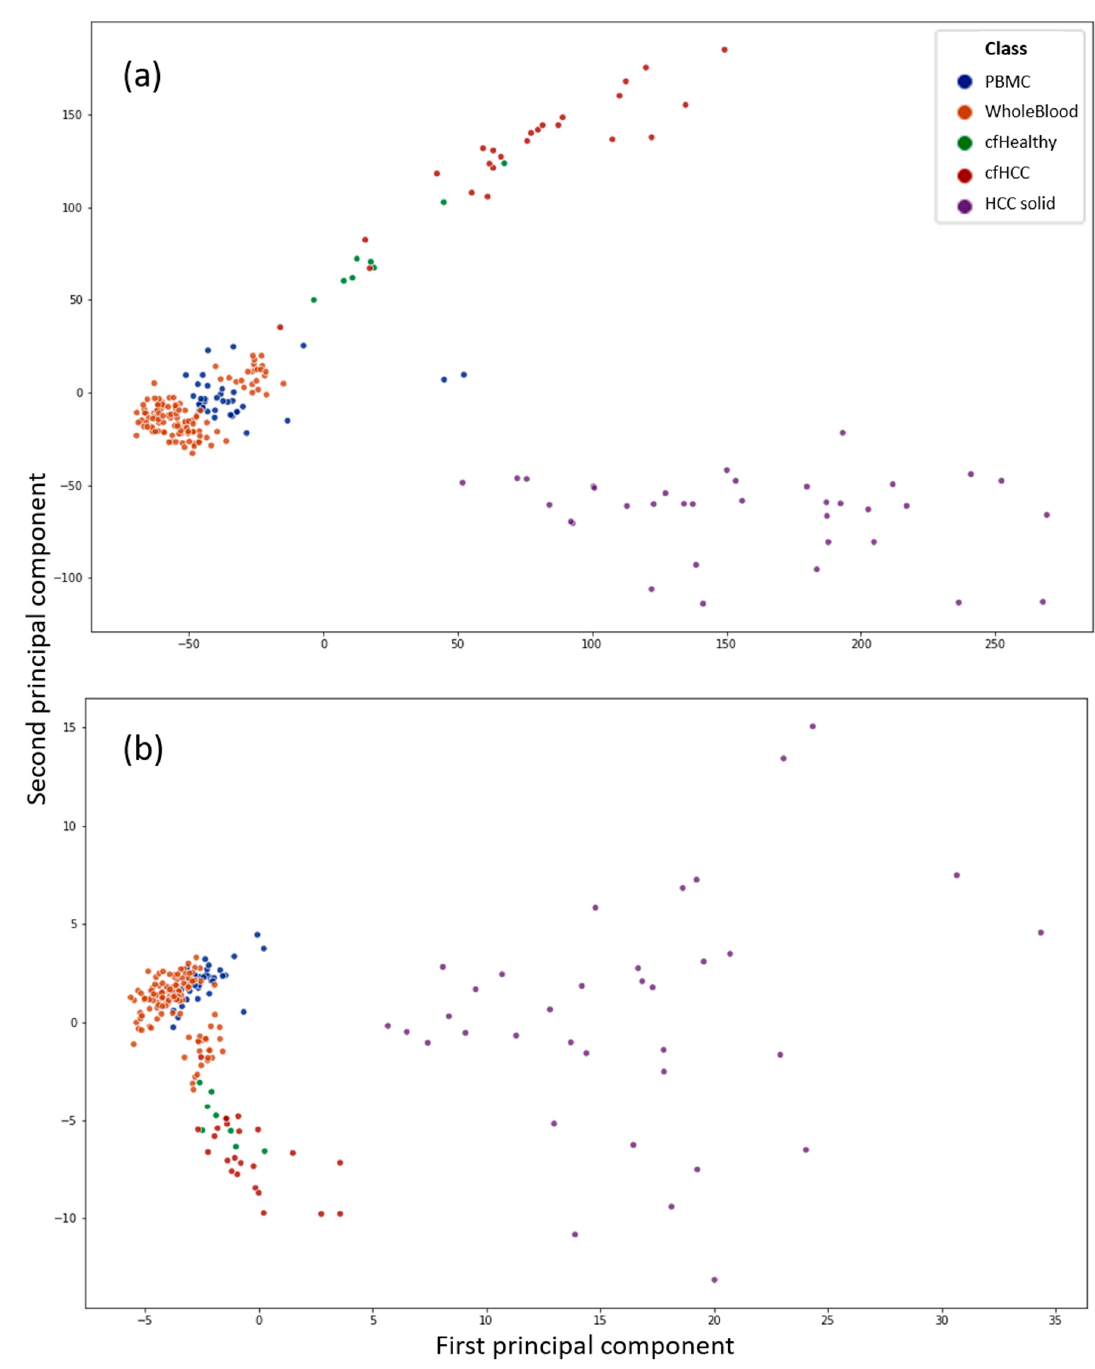
Figure 1. Principal component analysis (PCA) of the complete dataset. The features were in the form of CpG sites in ( a ) or computed CpG islands in ( b ). Blue is associated to purified peripheral blood mononuclear cell (PBMC) samples, while orange shows whole blood samples, where the complete DNA that can be found in a blood sample is extracted without further purification. The violet dots represent solid hepatocellular carcinoma (HCC) samples. Green and red are healthy and cancerous cfDNA samples extracted from plasma, respectively. The highest red dot in ( b ) located between the lower orange cluster is the sample cfDNA_6032742_Cirrhosis_with_HCC, which is the most mispredicted sample by all classifiers. In ( a ), it is the lowest red dot in proximity to the blood sample cluster.